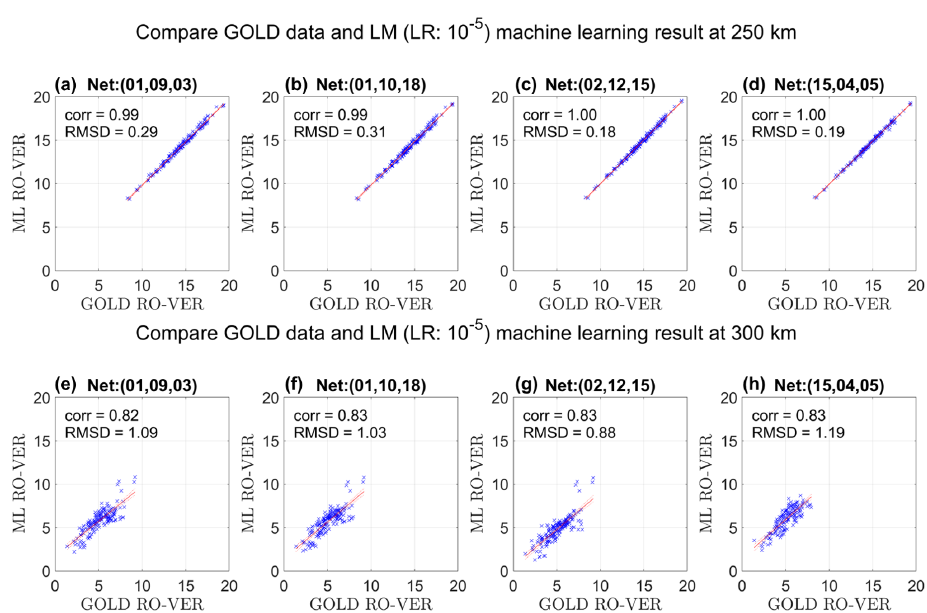
Figure 6. Similar to Figures 4 and 5, but trained with LM algorithm. From left to right, the nets with the number of neurons in three HDLs are (01, 09, 03), (01, 10, 18), (02, 12, 15), and (15, 04, 05) at ( a – d ) 250 km and ( e – h ) 300